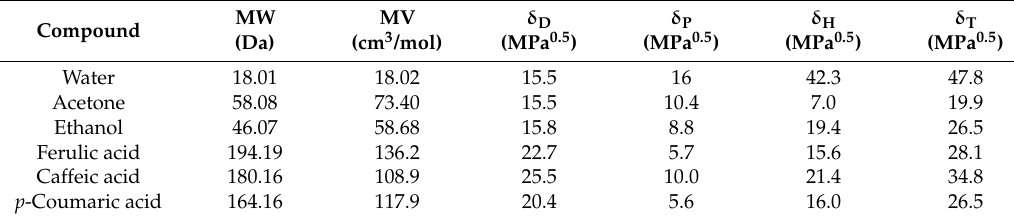
Figure 4. Molecular structures of the three major phenolic compounds in BSG.